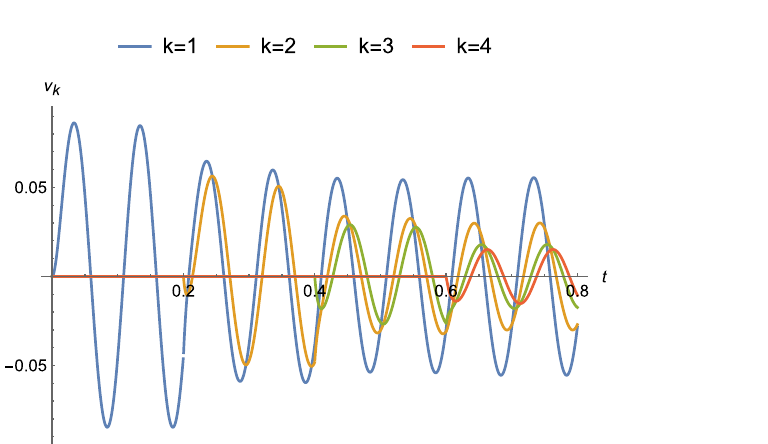
Figure 11. Complete response for parameters that approximate an axon ( α = 10 − 6 , R = 10 12 � , C = 10 − 8 F , and ν 0 ( t ) = 100 sin (ω t + φ) mV with ω = 20 π (rad/s)) under binding regime that approximates diffusion- limited growth with a time between attachments of T = 0.2